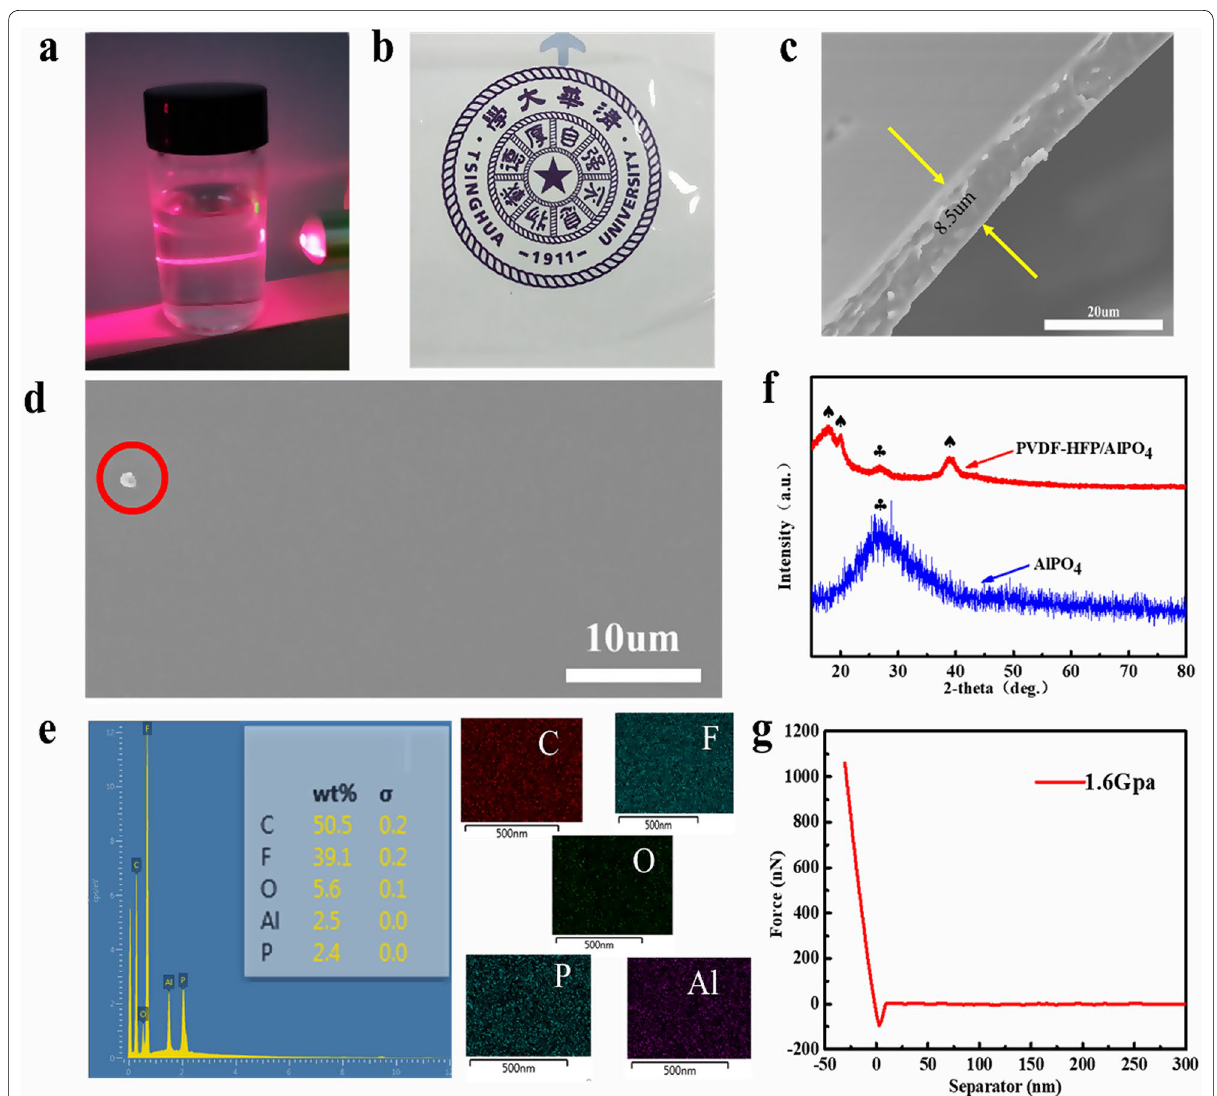
Fig. 2 Material characterization: a Tyndall effect of PVDF-HFP- AlPO 4 solution; b digital photograph of transparent PAF; c cross-sectional and d top-view SEM images of PAF; e EDS spectrum and element maps of PAF; f XRD patterns of pristine AlPO 4 and PAF; and g the force-distance curve and corresponding Young’s modulus of PAF, measured by atomic force